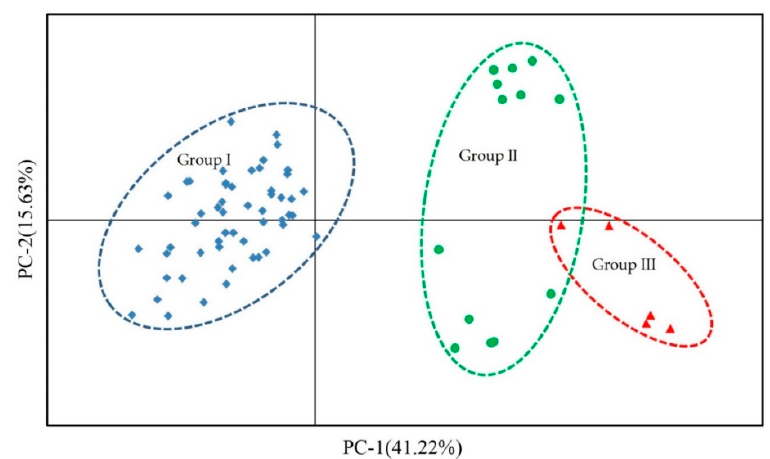
Figure 5. Principal coordinate analysis (PCoA) of 72 individuals of three species Liquidambar based on 20 EST-SSR markers. The blue squares represent L. formosana, the green filled circles represent hybrid sweetgum and the red triangles represent L. styraciflua. The first two coordinates explain percentages of total variation for 41.22% and 15.63%, respectively.